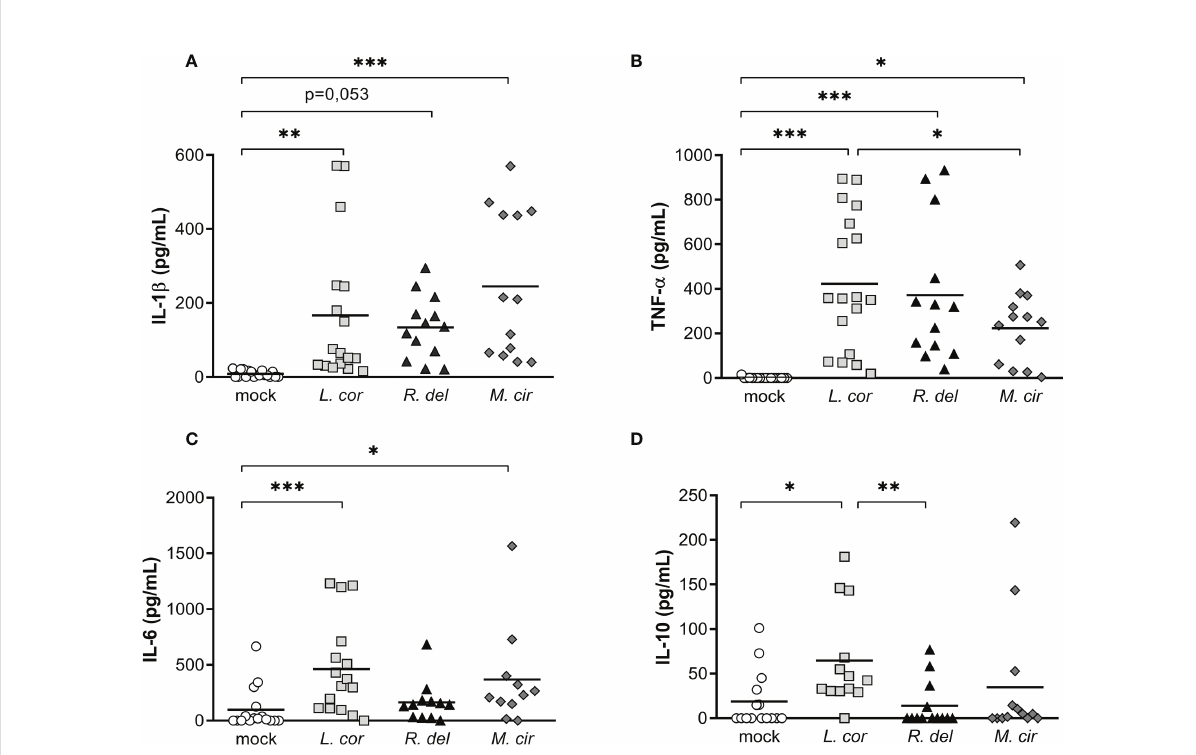
FIGURE 3 Resting spores of the virulent strain of L corymbifera induce a higher production of TNF- a , IL-6, and IL-10 compared tothe clinical reference strains R. delemar and M. circinelloides . (A – C) Monocytes ’ pro-in fl ammatory cytokine and (D) anti-in fl ammatory IL-10 release after sixteen hours of exposure to alive spores of the most common pathogenic Mucorales. Lines represent the mean of data obtained from six independent experiments, each with two or three different donors, which are represented by symbols. Differences among groups were assessed by one-way ANOVA for normally distributed data and Krustal-Wallis for non-normally distributed. * p < 0,05; ** p <0,01; *** p <0,001. L corymbifera (L.cor), R. delemar (R. del), M. circinelloides